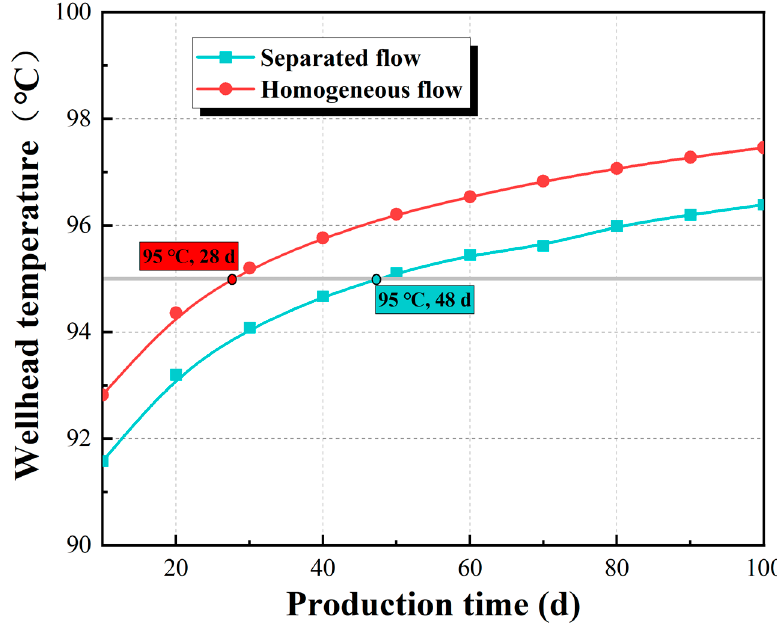
Figure 12. The influence of production time on wellhead temperature.